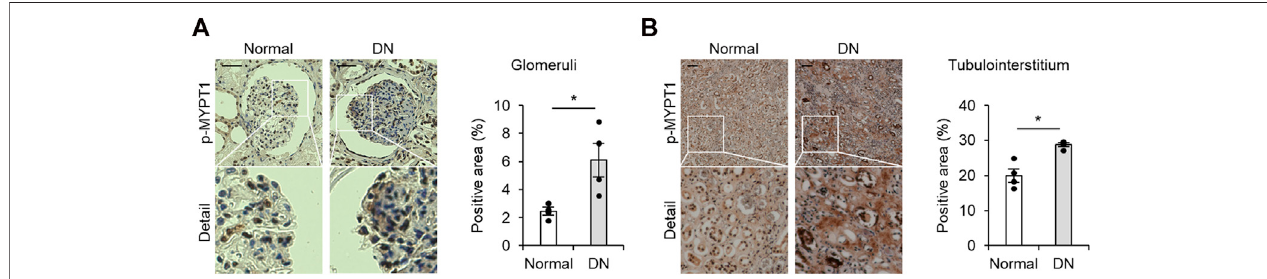
FIGURE1 | Activated ROCK signaling inpatientswith diabetic nephropathy (A) Representativeimages ofp-MYPT1 stainingin the glomeruli ofhealthy donors and patientswith diabetic nephropathy (DN). The glomerular-positive areawas calculated asthe ratioofthe p-MYPT1-positive areatothe glomerular tuftarea. Thescale bar onthetopleftpresents50 μ mp-MYPT1,phosphorylatedformofMYPT1. (B) Representativeimagesoftubulointerstitumstainedwithanantibodyagainstp-MYPT1(n (cid:1) 4). Thepercentageofthep-MYPT1-positiveareainthekidneyswasevaluated.Thescalebar onthetopleftpresents 100 μ m*p < 0.05.Datarepresent themean ± s.e.m.https://www.frontiersin.org/about/author-guidelines.